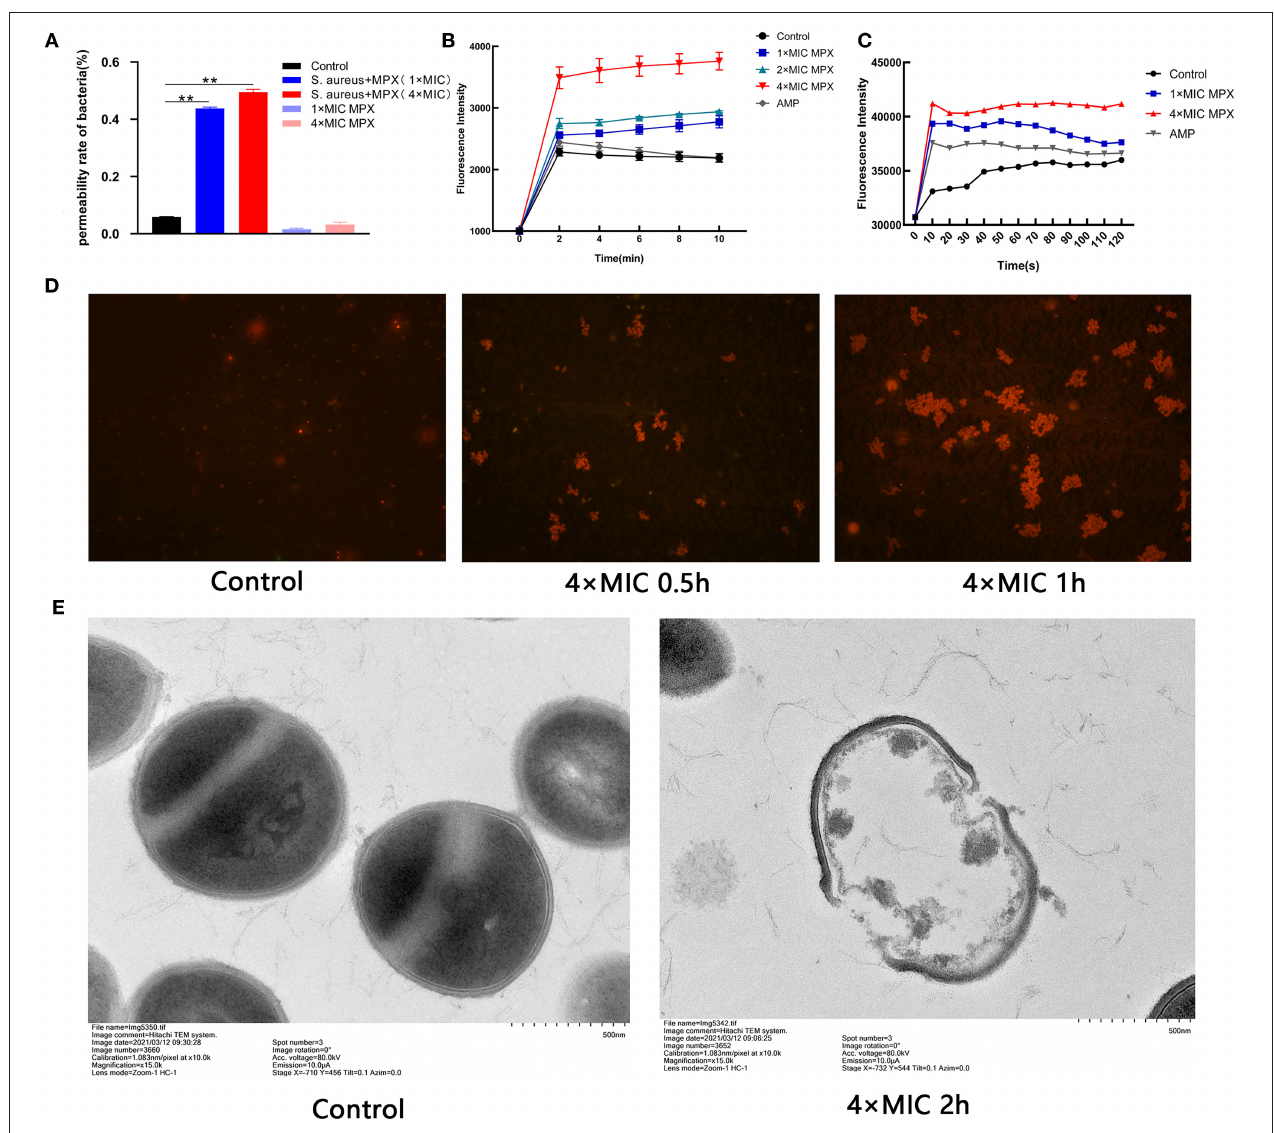
FIGURE 3 | The mechanism of action of MPX activity on S. aureus . (A) The BCA kit was used to detect the results of total protein content in bacterial supernatant. (B) Uptake of NPN by S. aureus treated with MPX. (C) DiSC3-5 was used to detect changes in the membrane potential of S. aureus after MPX treatment. (D) Fluorescence microscopy observation of PI staining after MPX treatment. (E) Visual observation of the mechanism of MPX on S. aureus ATCC 25923 by transmission electron microscopy. Error bars indicate the mean ± SEM, n = 3. Statistical significance was defined as ** p <